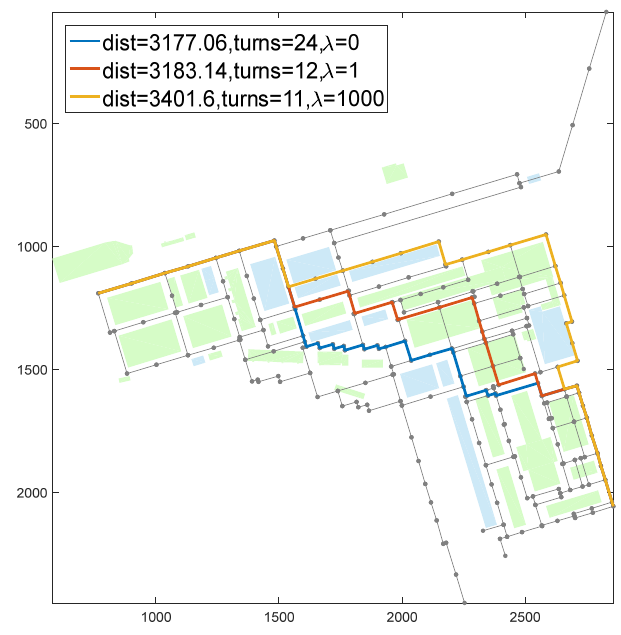
Figure 10. Influence of λ on the optimal path.